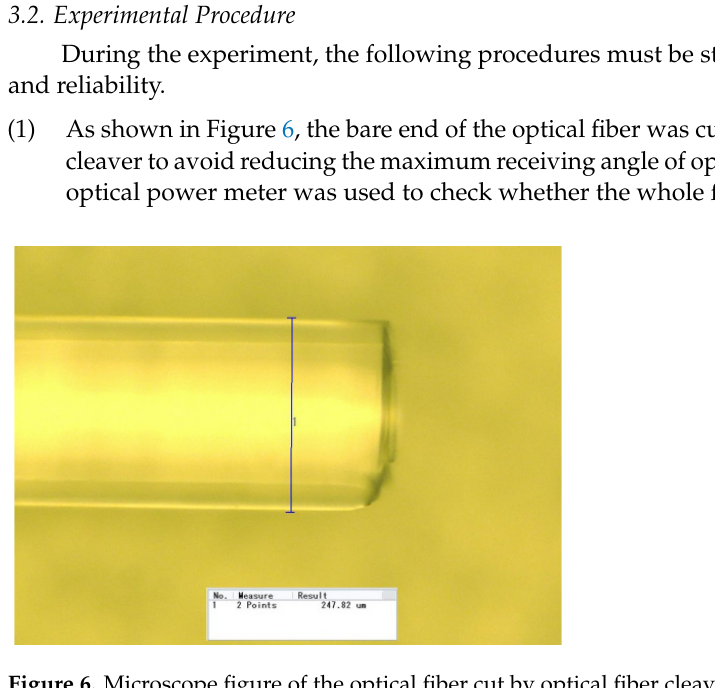
Figure 7. The installation site. Figure 8. Assembled apparatus for detonation velocity measurement.